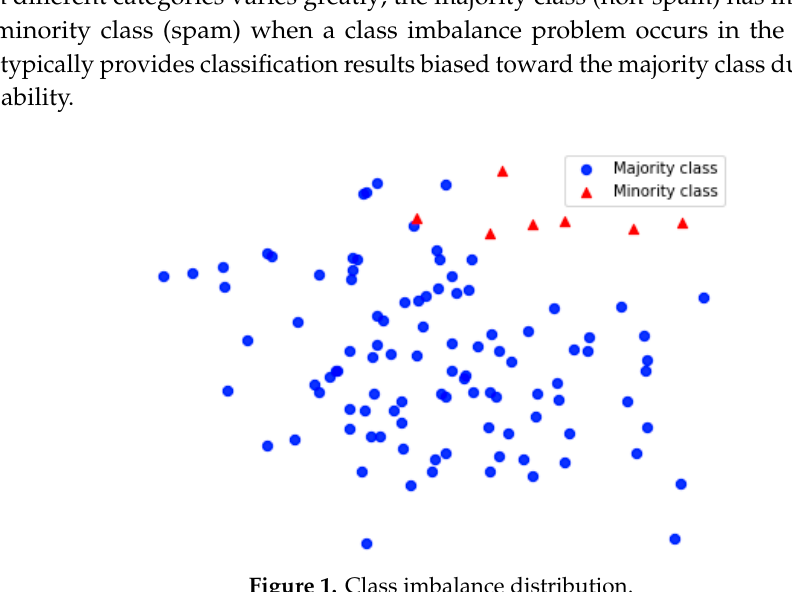
Figure 1. Class imbalance distribution.